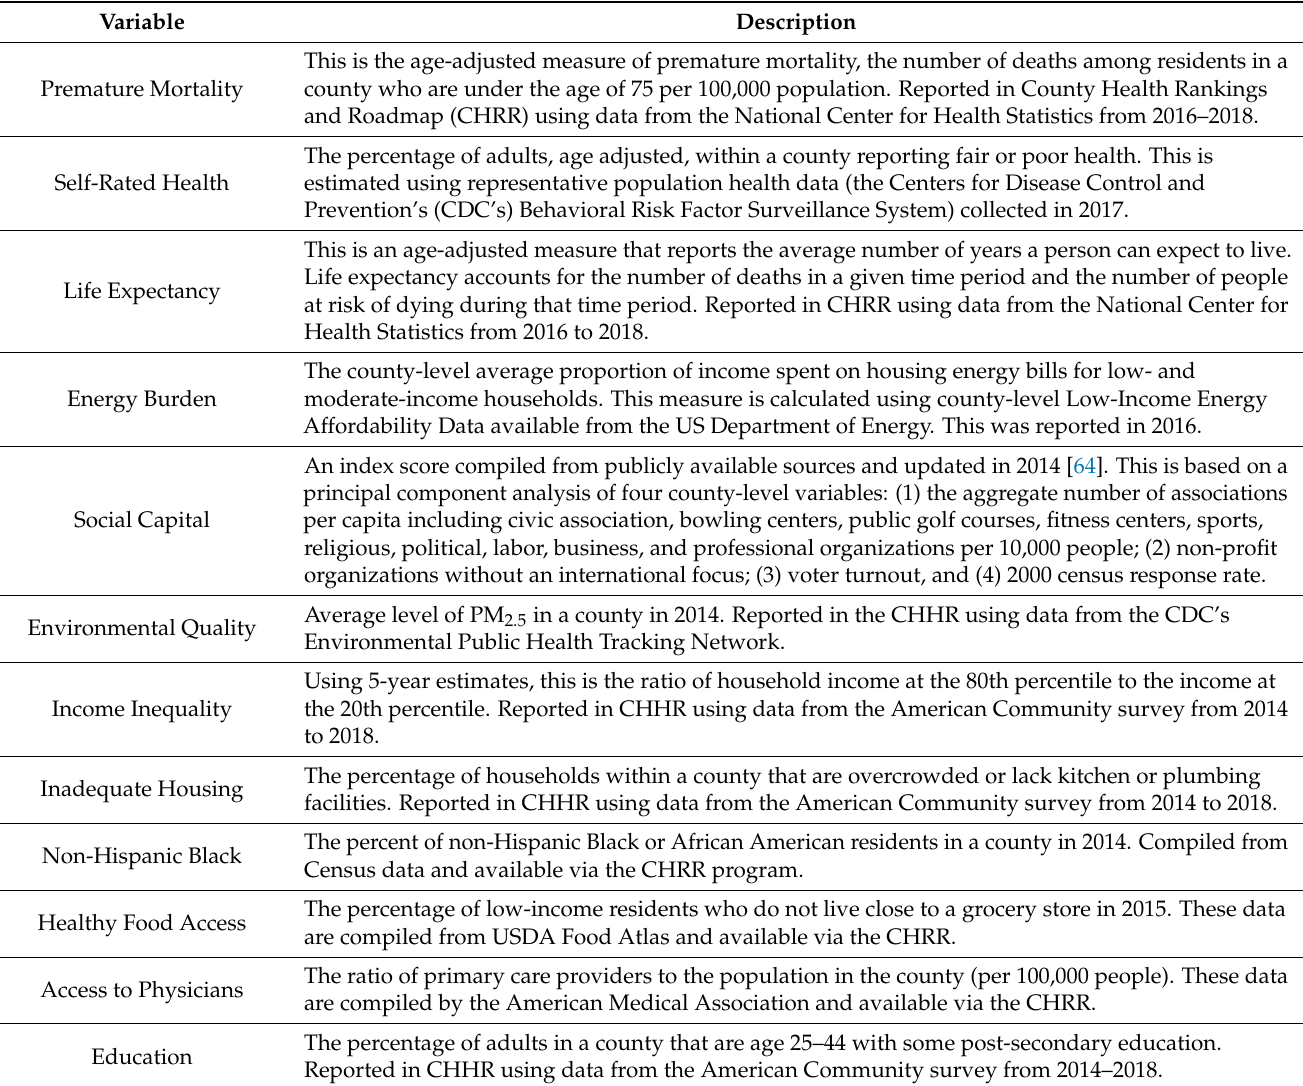
Table 1. Description of